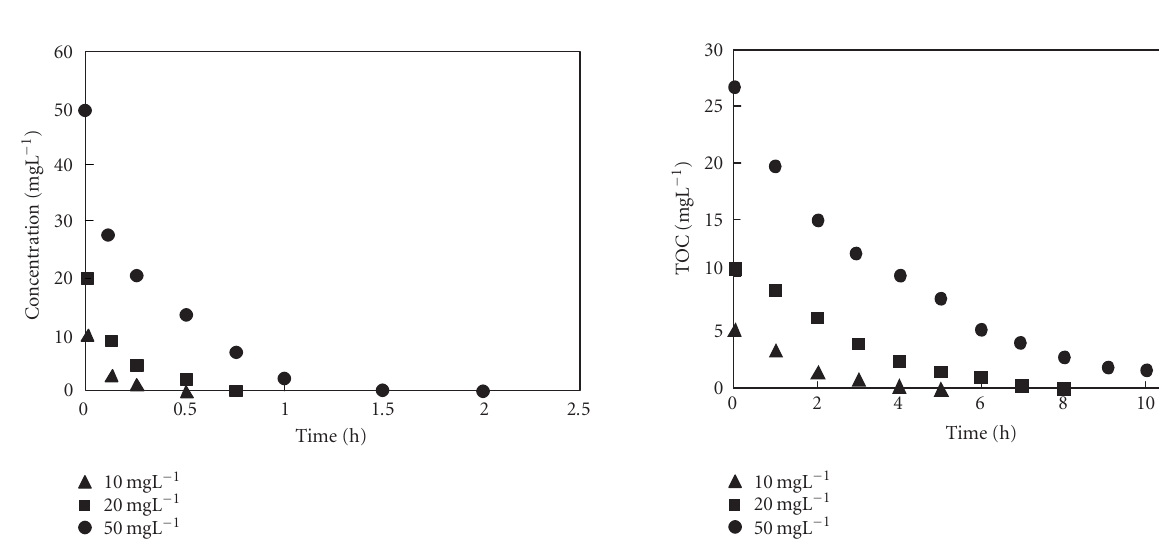
Figure 1: Photochemical degradation of aqueous solutions of lin- comycin.